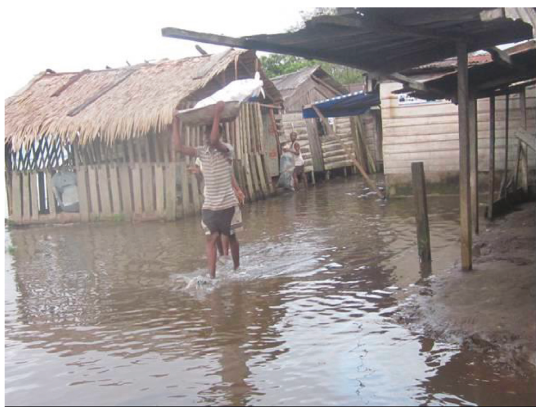
Figure 9: Case of flooding affecting houses in Kwansi